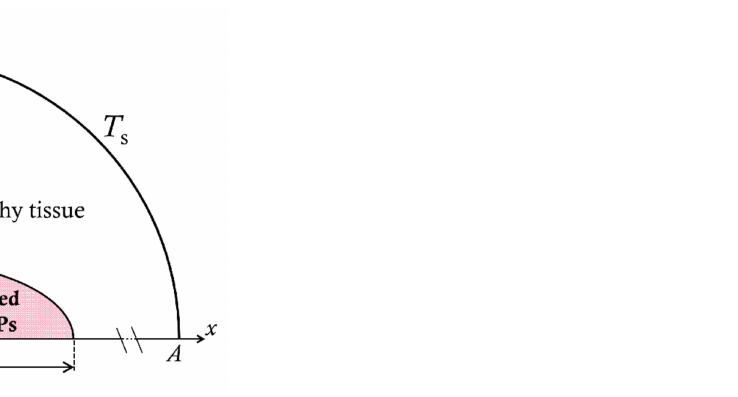
Figure 2. Schematic representation of the axisymmetric model, where y -axis is the revolution axis and x -axis is a symmetry axis (figure not to scale). The ellipsoidal tumor is assumed to be surrounded by a significantly larger spherical healthy tissue ( R h >> a or b ). T s corresponds to the temperature of the outer surface of the healthy tissue.